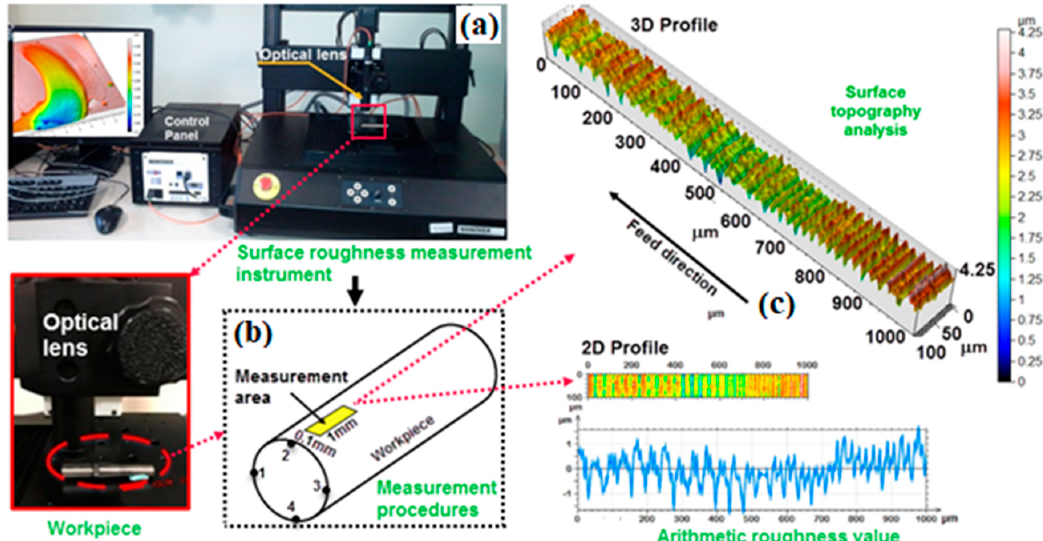
Figure 4. Measurement procedure of surface roughness in current work, ( a ) surface roughness tester; b ) area under consideration for the roughness measurement; c ) 3D surface topography of the area.